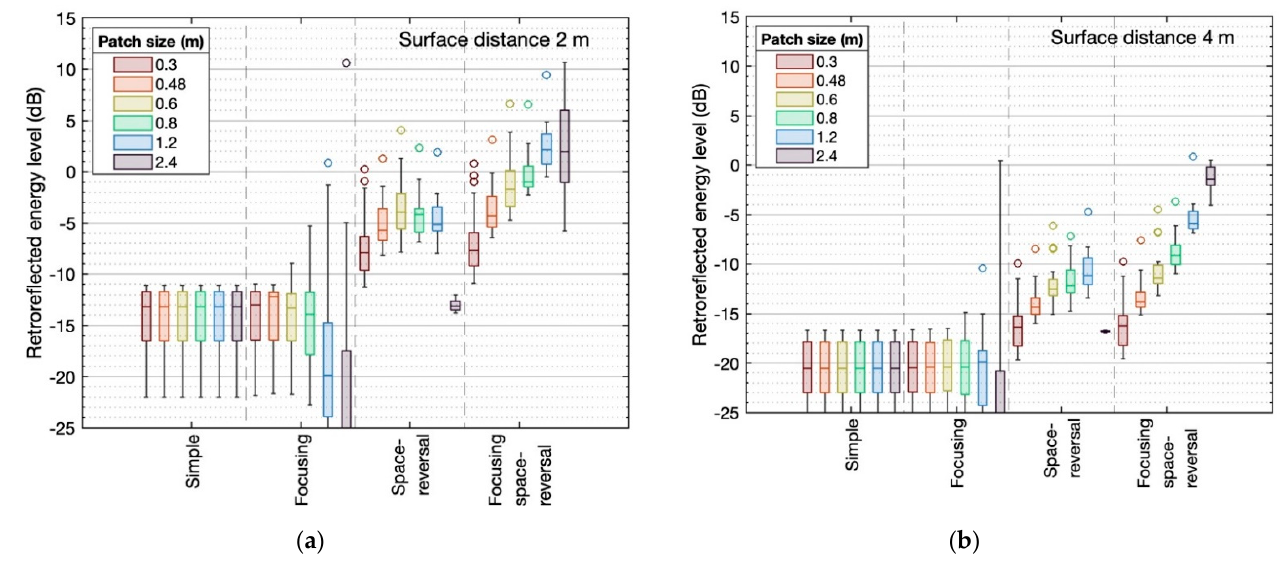
Figure 11. Distribution of retroreflected energy levels for 25 collocated source-receivers. The reflector is a 2.4 × 2.4 m square, and 25 source-receivers are in a 2.4 × 2.4 m square offset from the reflector